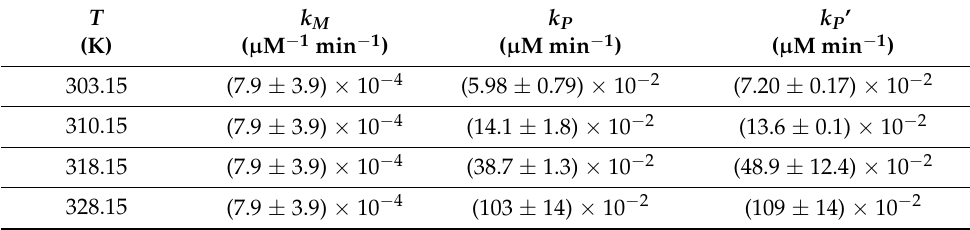
Table 1. Kinetic parameters of diuron